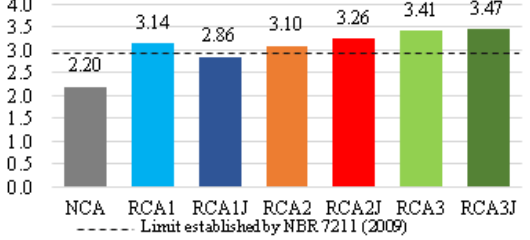
Figure 4. Shape index of the natural and recycled coarse aggregates from sources 1, 2 and 3, before and after jigging.